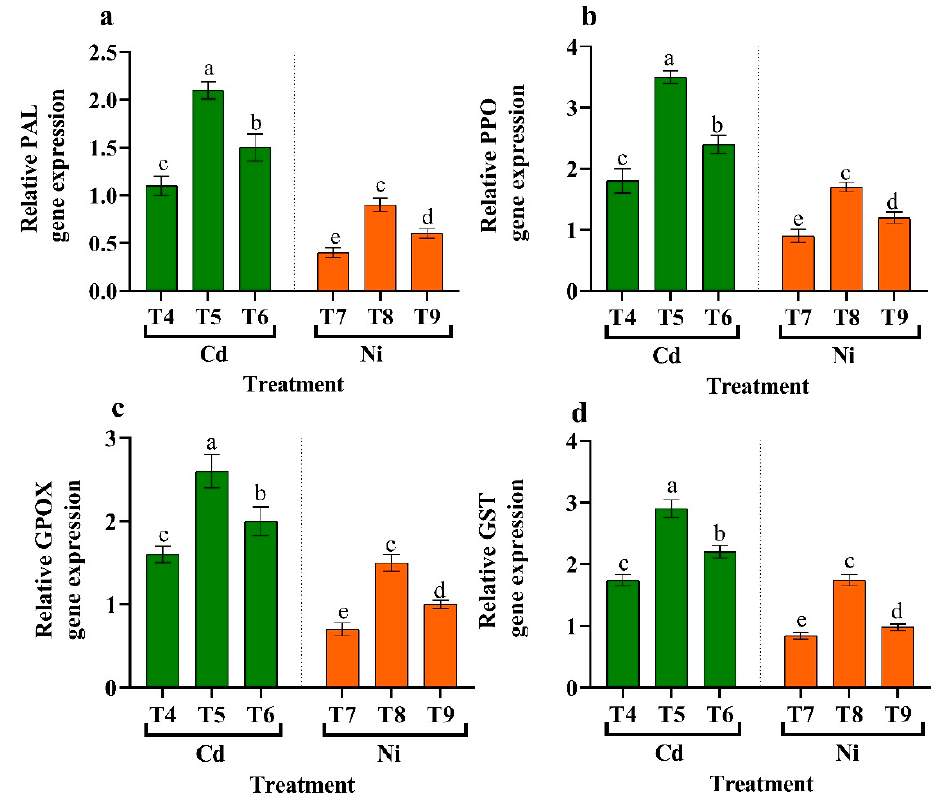
Figure 9. The influence of two endophytic bacteria on antioxidant enzyme gene expression (( a ) PAL gene, ( b ) PPO gene, ( c ) GPOX gene, and ( d ) GST gene) in tomato plants growing under HM stress. Fisher’s test at p < 0.05 reveals significant variations in means ( ± standard error) of different letters (a–e) on the same bars. T4: 50 µ M Cd, T5: Micrococcus luteus + 50 µ M Cd, T6 : Enterobacter cloacae + 50 µ M Cd T7: 50 µ M Ni, T8: Micrococcus luteus + 50 µ M Ni, T9 : Enterobacter cloacae + 50 µ M Ni.